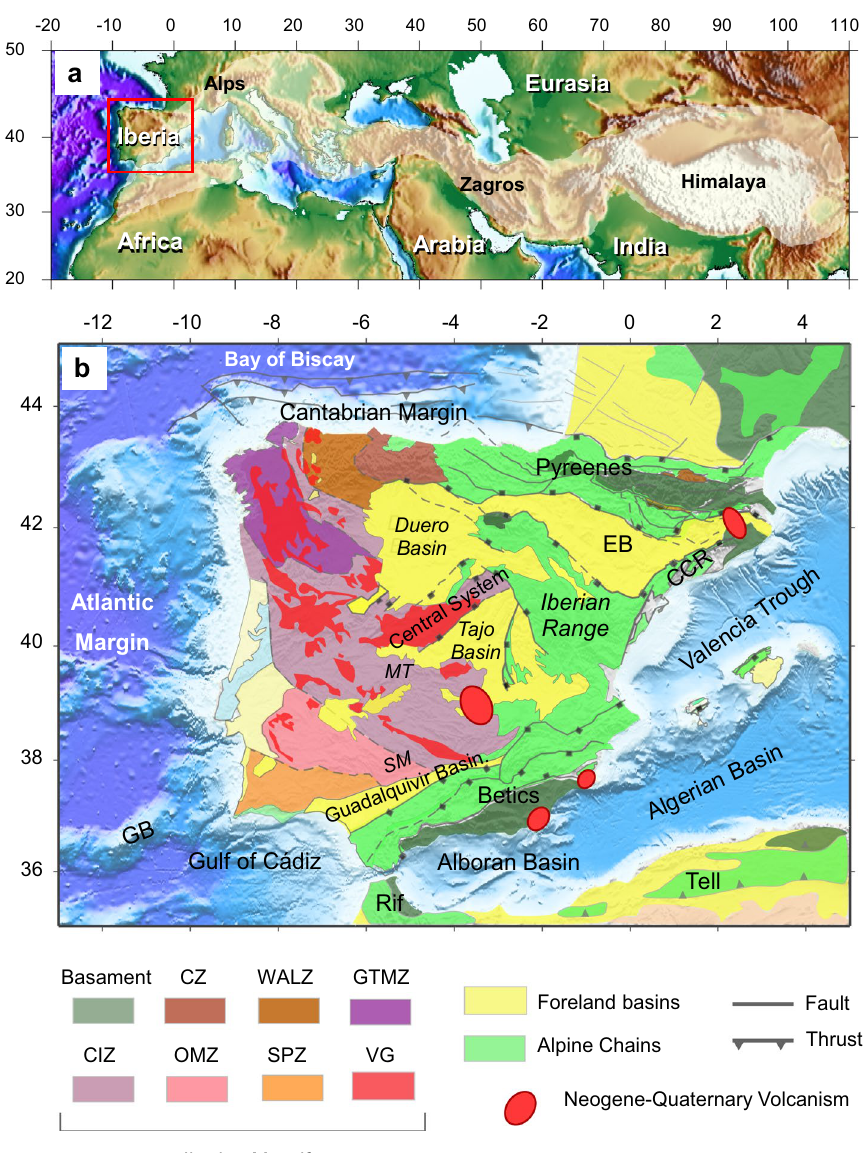
Fig. 1 a Topographic map of the Alpine–Himalayan collisional zone shown as shaded area. Red square shows location of the study area. b Simplified geological map of the Iberian Peninsula. Abbreviations of the Iberian Massif: CZ—Cantabrian Zone; AOLZ—Western‑Asturian–Leonese Zone; GMZ—Galicia‑Tras‑os‑Montes Zone; CIZ—Central IberianZone; OMZ ‑Ossa Morena Zone; SPZ—South Portuguese Zone; VG—Variscan Granotids. Alpine terranes: CR—Catalan Coastal Ranges; EB—Ebro Basin. MT—Montes de Toledo. SM—Sierra Morena. GB—Gorringe Bank. Modified from Torne et al.